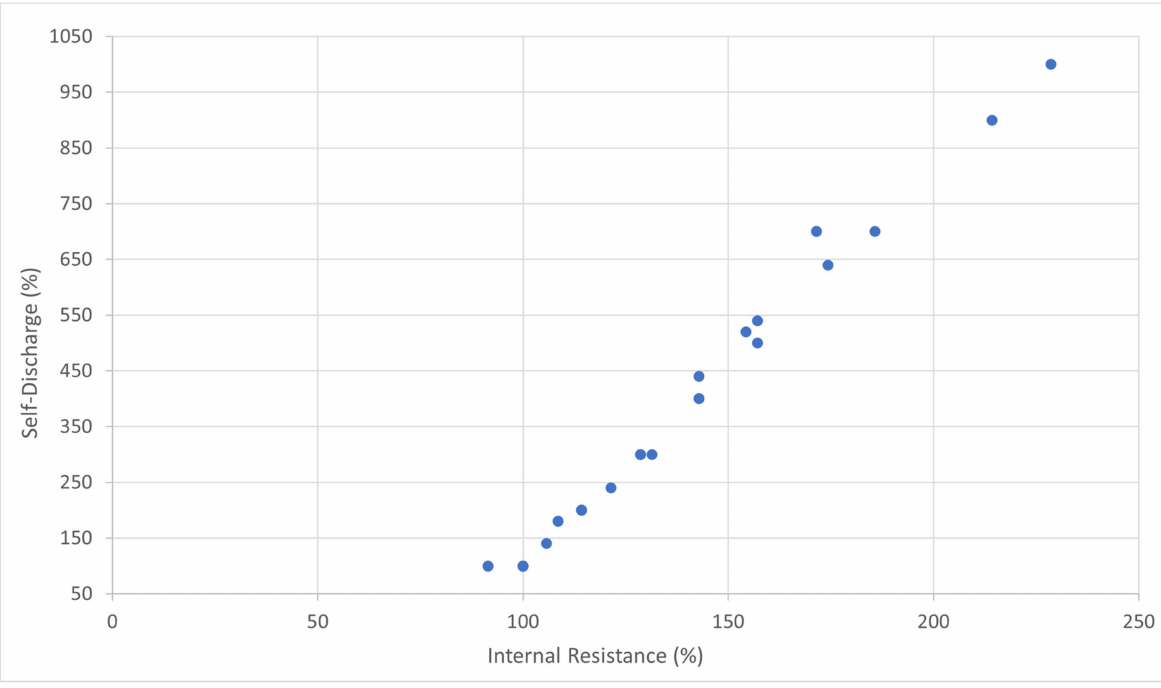
Figure 5. Internal resistance vs. relaxation voltage